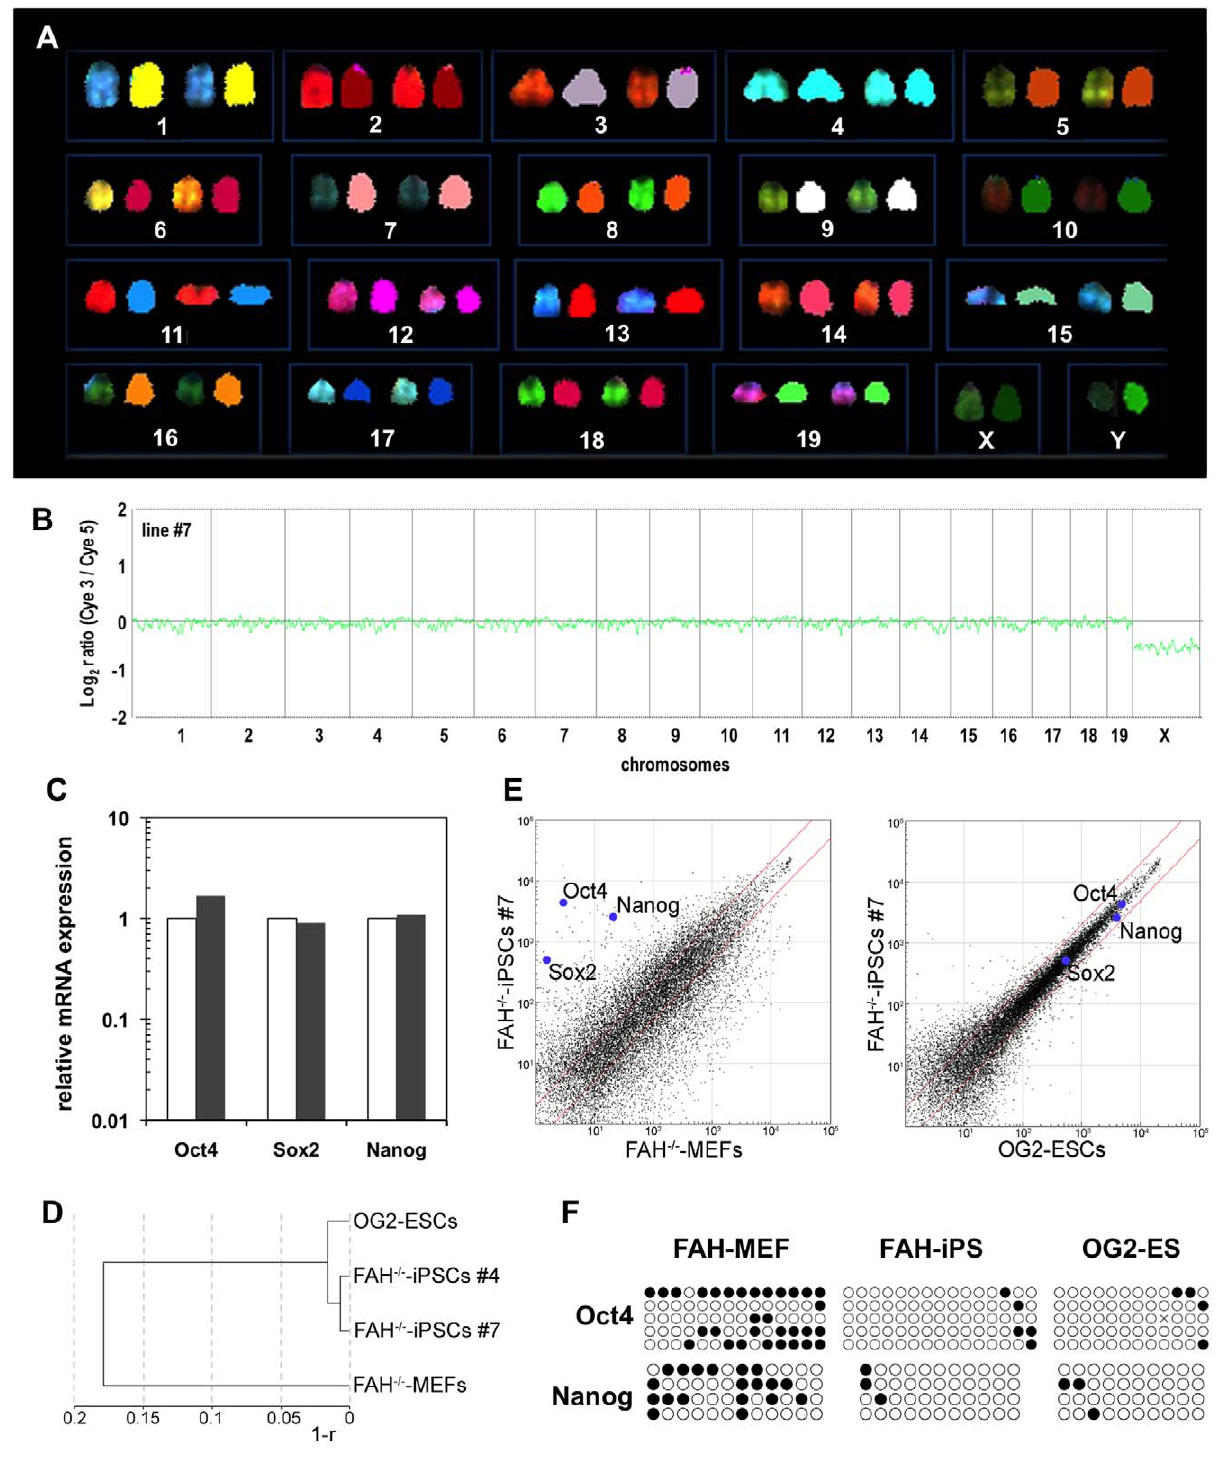
Figure 2. Molecular characterization of FAH 2 / 2 -iPS cells. (A) SKY analysis of line # 7 showed a normal male karyotype (40, XY) without any signs of chromosomal abnormalities. Each chromosome is depicted in original fluorescence color (left) and after classification (right). (B) Array CGH analyses of the male FAH 2 / 2 –iPS cell line # 7 compared with the sex-mixed starting fibroblast (MEF) population further conformed its normal karyotype. (C) Quantitative RT-PCR for the pluripotency factors Oct4 , Sox2 , and Nanog in FAH 2 / 2 -iPS cells compared with OG2 ES cells (normalized to 1). (D) Hierarchical clustering dendrogram of FAH 2 / 2 -iPS cell lines based on global expression profile similarity (r: linear correlation coefficient). (E) Scatter plot of global gene expression data comparing FAH 2 / 2 -iPS cells with FAH 2 / 2 -MEFs (left panel) and FAH 2 / 2 -iPS cells with ES cells (right panel). (F) Methylation status of Oct4 - and Nanog -promoter regions in fibroblasts (starting cells: FAH 2 / 2 -MEFs), FAH 2 / 2 -iPS cells, and OG2 ES cells. Black circles depict methylated CpG islets; white circles show unmethylated CpG islets.